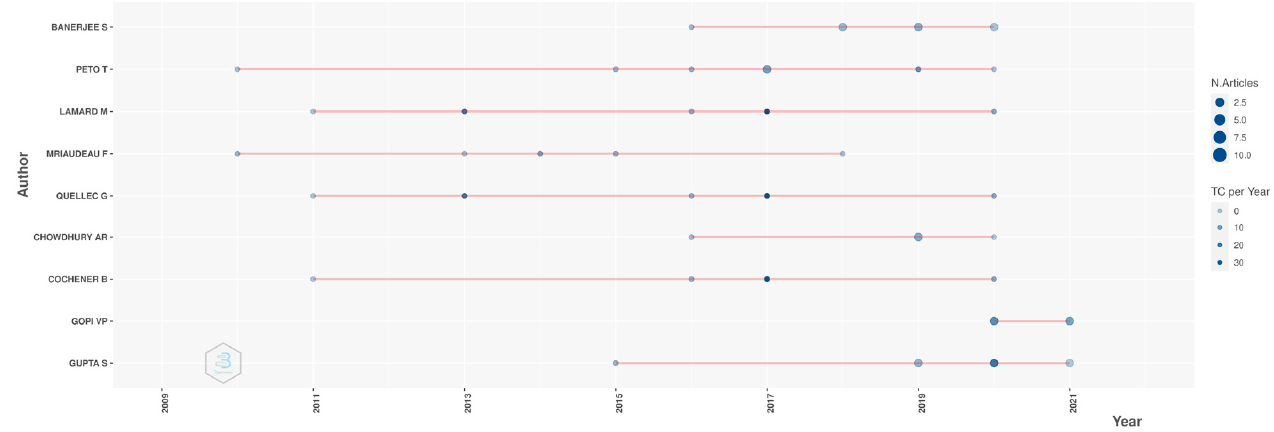
Figure 13. Top 10 authors’ production over time.